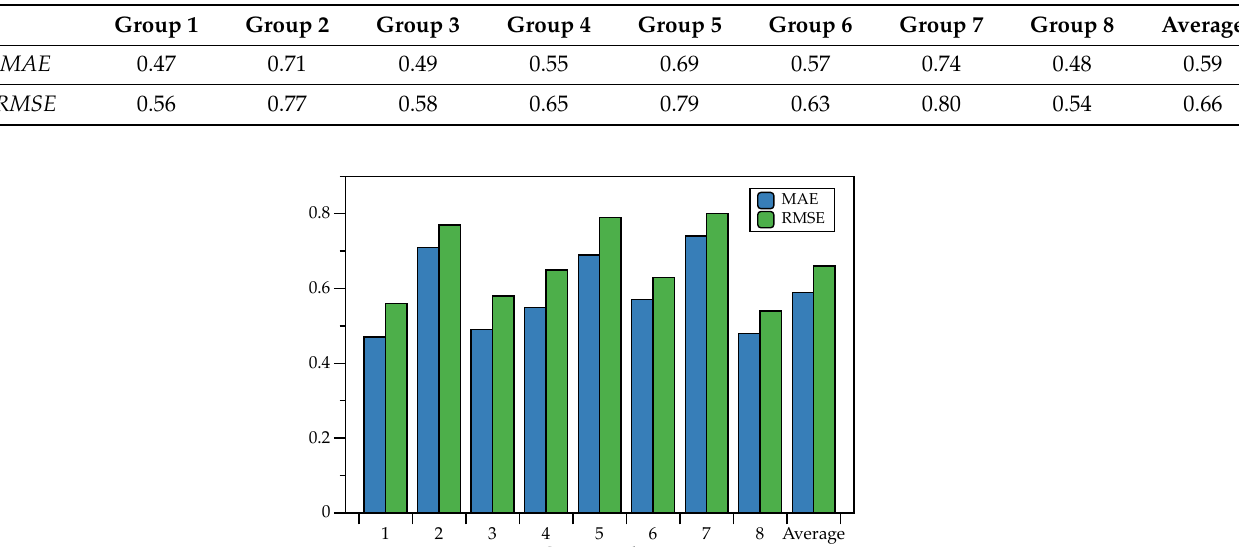
Table 5. Summary of MAE and RMSE of other experimental groups.